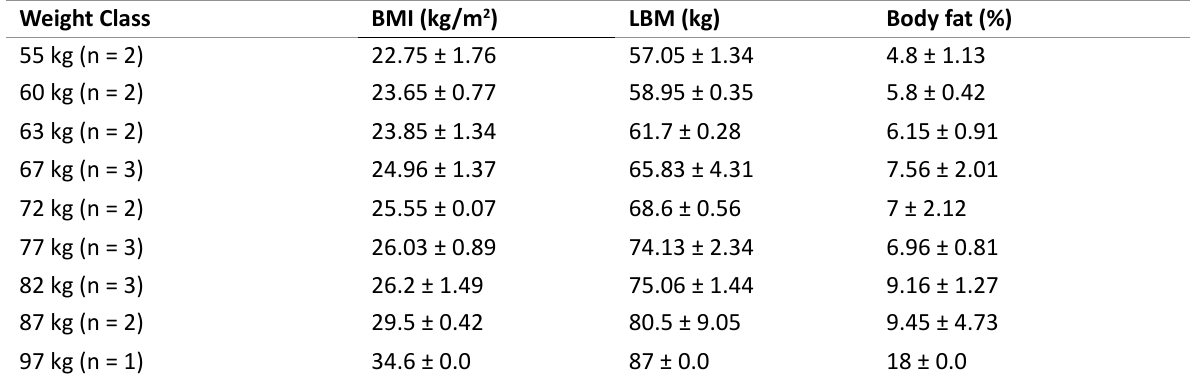
Table 2. Mean and standard deviation of the body composition of the elite Azerbaijani senior Greco-Roman wrestlers Weight